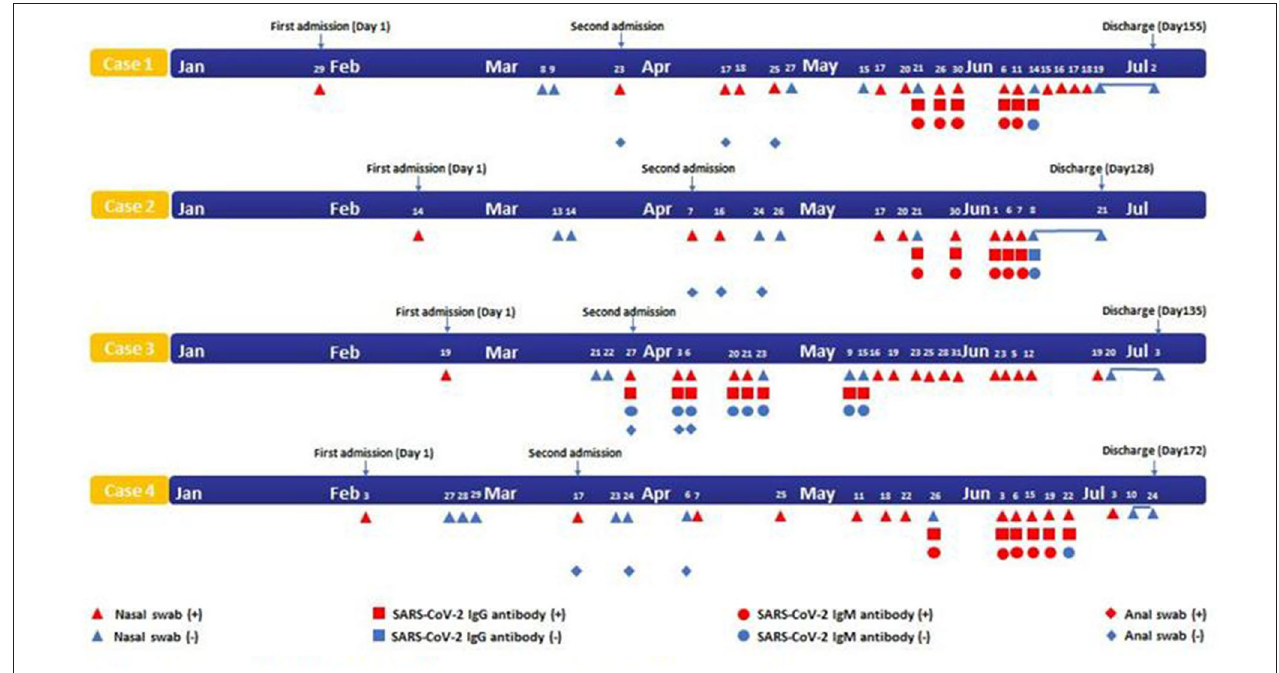
FIGURE 2 | Timeline of four cases with SARS-CoV-2 infection. SARS-CoV-2, Severe acute respiratory syndrome coronavirus